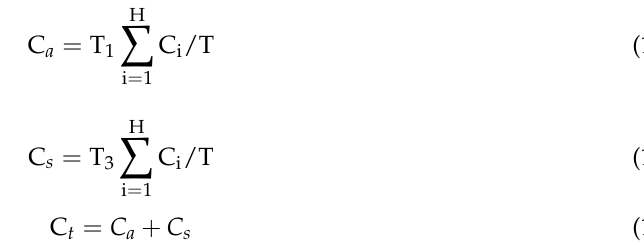
Figure 4. Percentage of the time period occupied by different sea conditions at the study site from 19 December 2016 to 11 January 2017.